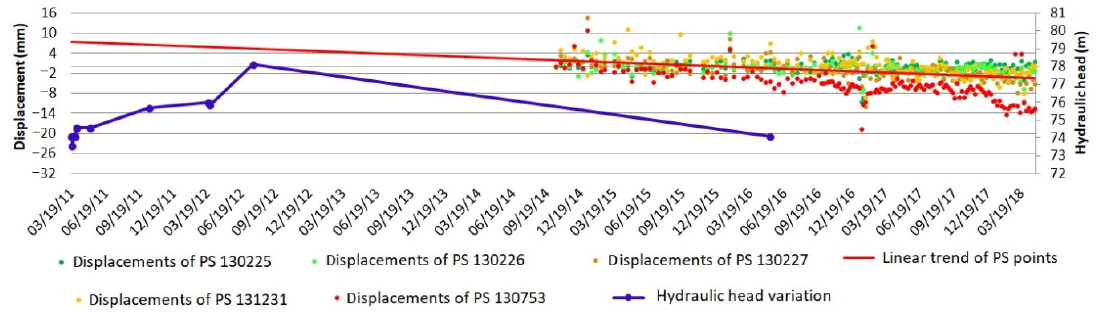
Figure 15. Comparison between the evolution of hydraulic head data for TrEiff borehole and displacements (left y -axis indicates displacements, right y -axis indicates hydraulic head variation, x -axis indicates time): PS points from 109 Descending orbit.